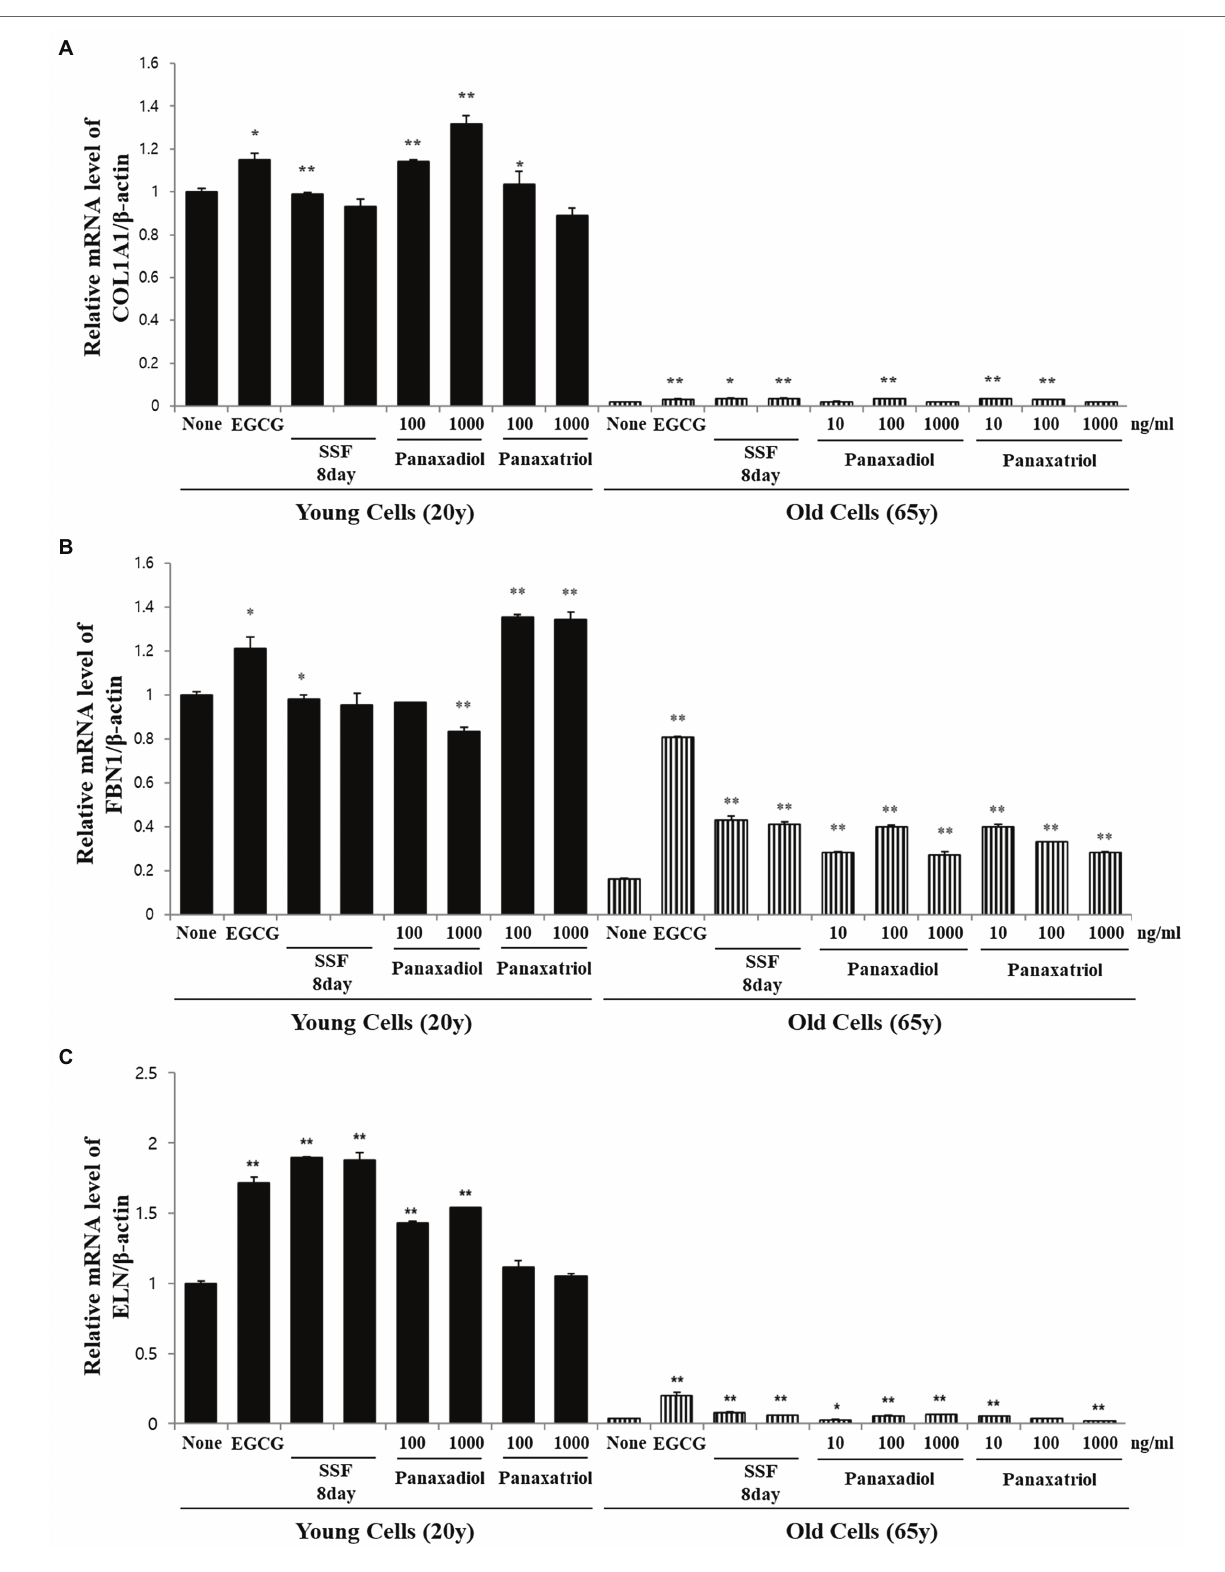
FIGURE 5 | Relative mRNA expression levels of (A) COLA1, (B) FBN1, and (C) ELN in primary normal HDFS treated with protopanaxadiol and protopanaxatriol. * p < 0.05, ** p < 0.01 vs.